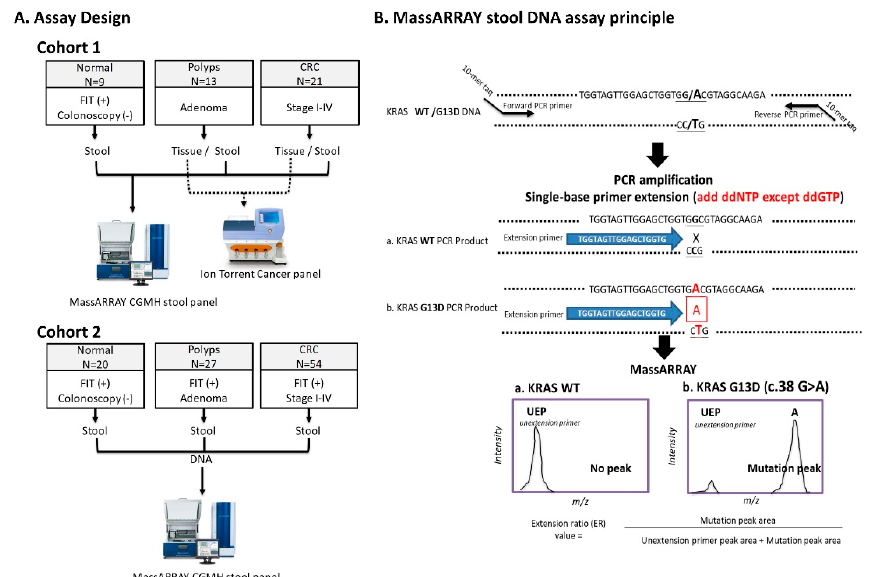
Figure 1. Assay design and the detection principles of the MassARRAY stool DNA panel. ( A ) Two cohorts that included normal, polyp-bearing, and CRC patients with available FIT data and colonoscopy results were separately used to evaluate the accuracy and clinical performance of the developed stool DNA (sDNA) assay. DNA from tissue samples with known DNA with mutation profiles, as previously assessed using the Cancer Hotspot Panel on Ion Personal Genome Machine, were collected, along with the corresponding paired pre-operational stool samples, from normal, polyp and CRC patients in cohort 1. Cohort 2 stool samples were collected from a FIT-positive population. All stool mutations were detected using the Sequenome MassARRAY platform. ( B ) Illustration of the principles and procedures of the single allele base extension reaction (SABER), using KRAS p.G13D as an example. UEP: unextension primer peak; m / z : mass-to-charge ratio; ER: extension ratio.